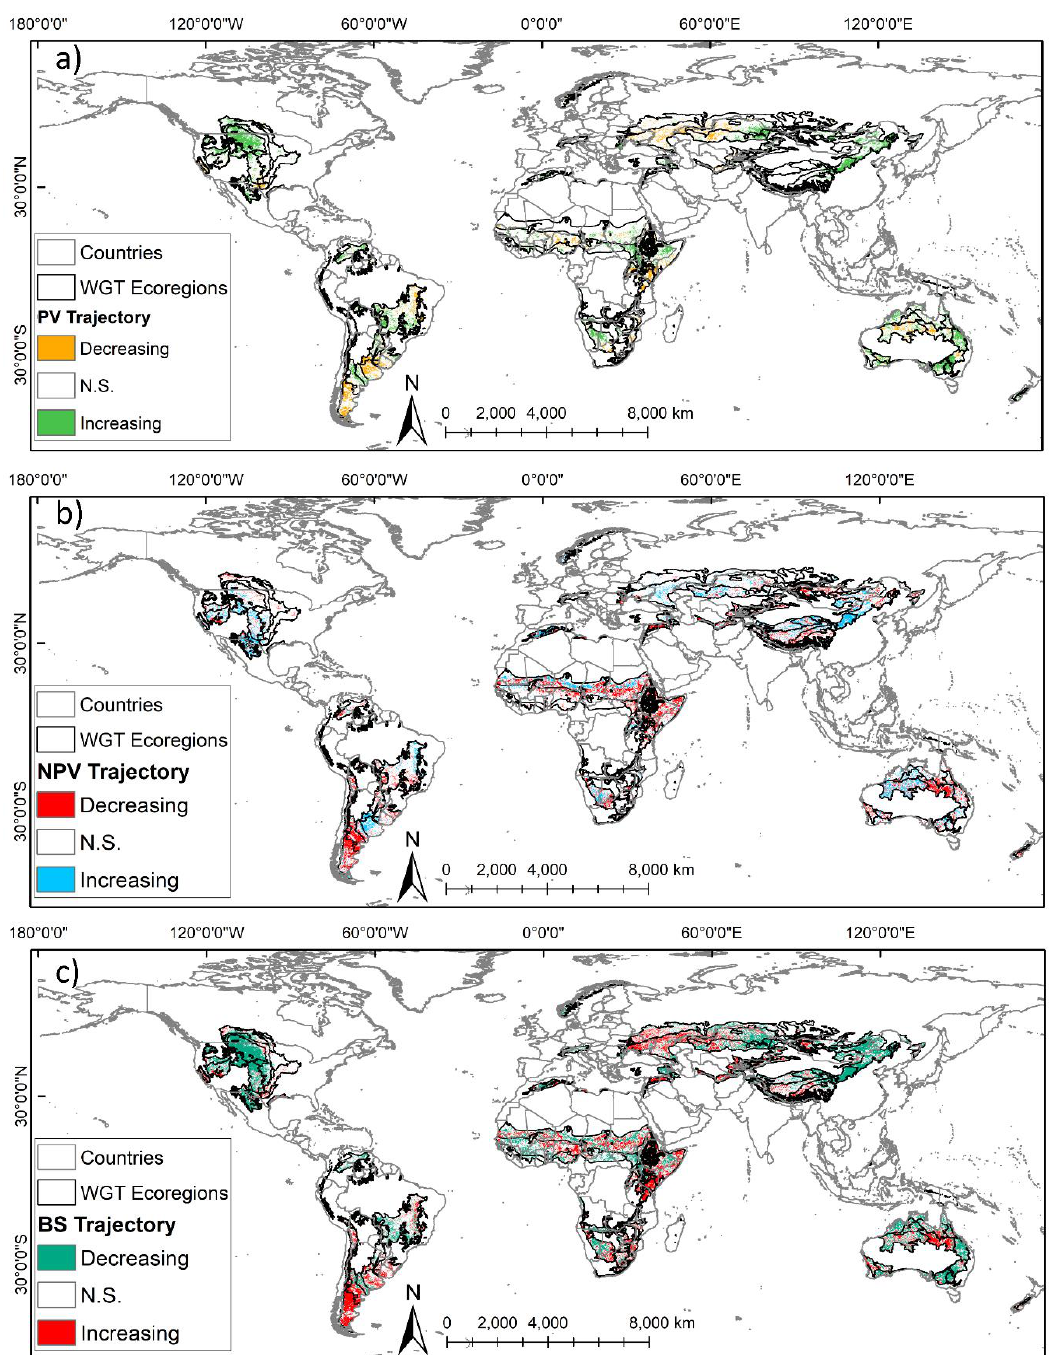
Figure 7. ( a ) Geographical pattern of significant (p < 0.1) positive or negative long-term trajectory of vegetation fractional cover for: F PV ; ( b ) Geographical pattern of significant (p < 0.1) positive or negative long-term trajectory of vegetation fractional cover for F NPV ; and ( c ) Geographical pattern of significant (p < 0.1) positive or negative long-term trajectory of vegetation fractional cover for F BS .